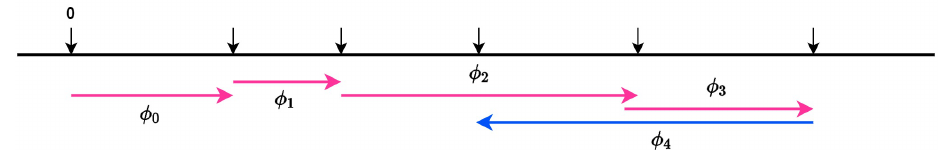
Figure 11. Visualization of SHAP